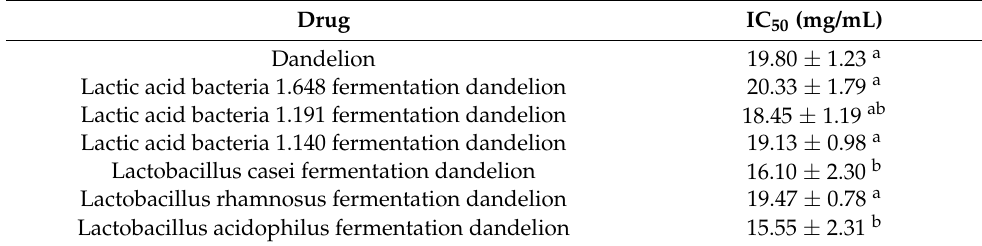
Table 2. IC 50 of dandelion and each fermentation solution on XOD.